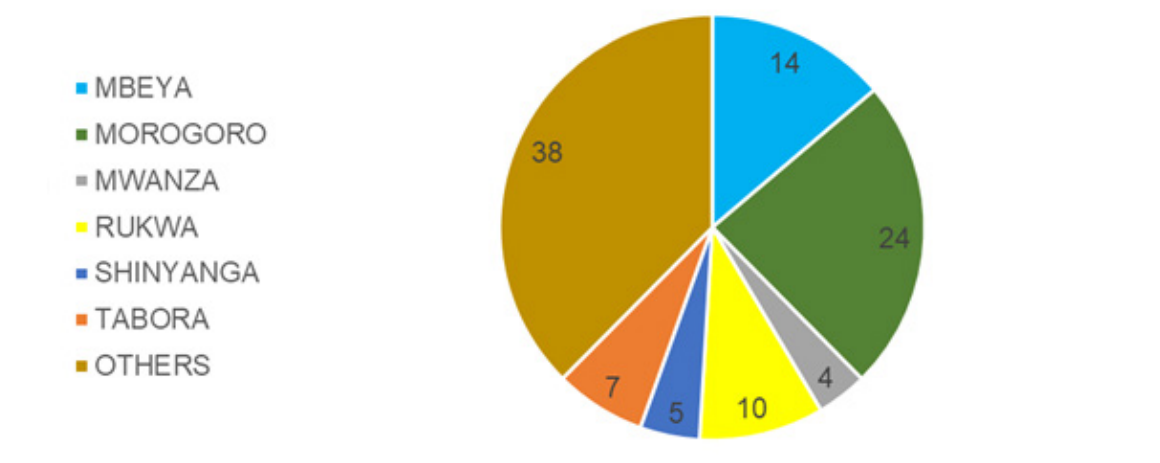
Data source: Tanzanian Ministry of Agriculture 24 Figure 3: Region-wise share (%) of rice production in Tanzania for